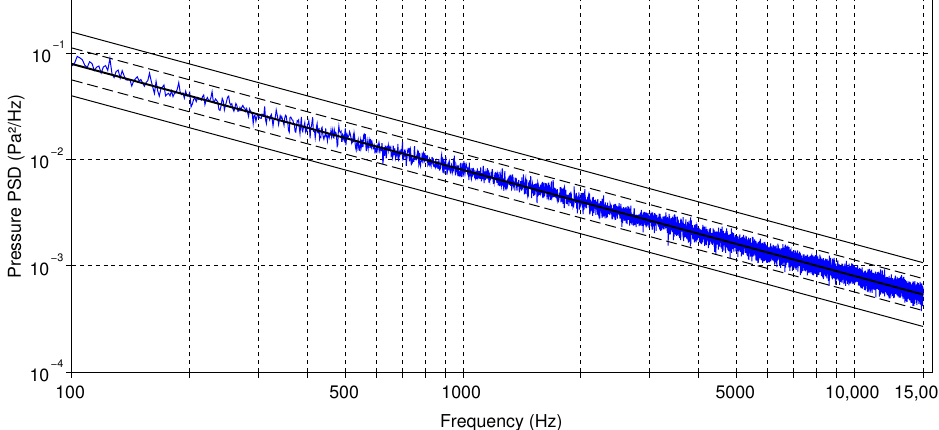
Figure 4. The mean pressure PSD of the six microphones (blue) compared with the control (thick line), ± 3 dB envelope (dashed lines) and ± 6 dB envelope (thin